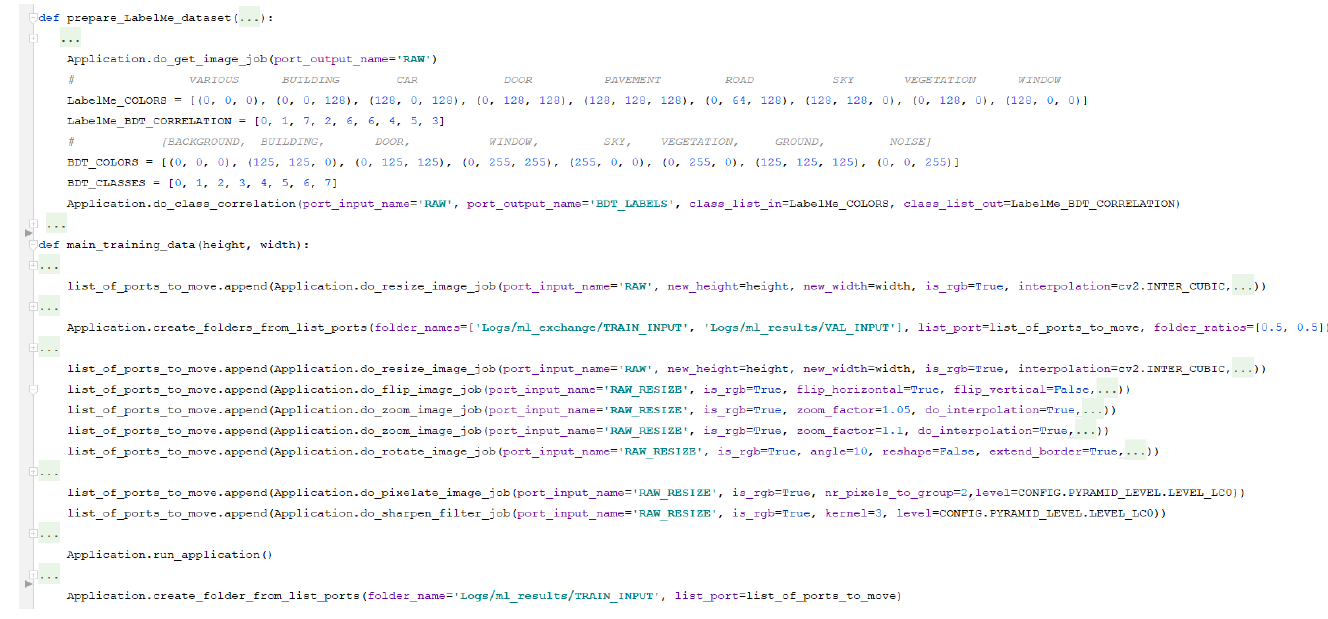
Figure 12. Code snipe of data preparation for